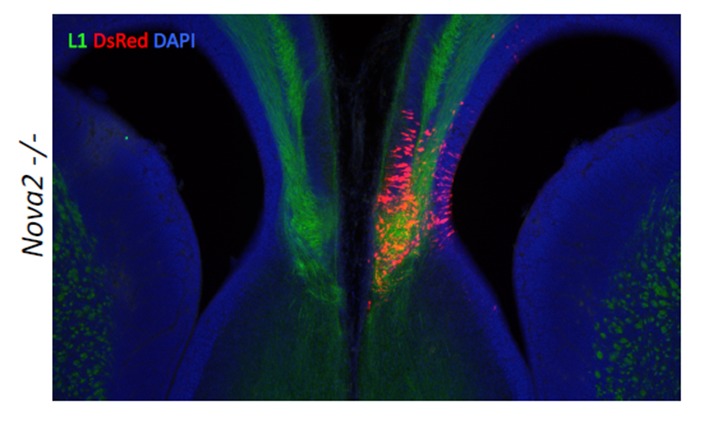
DOI:
http://dx.doi.org/10.7554/eLife.14371.031